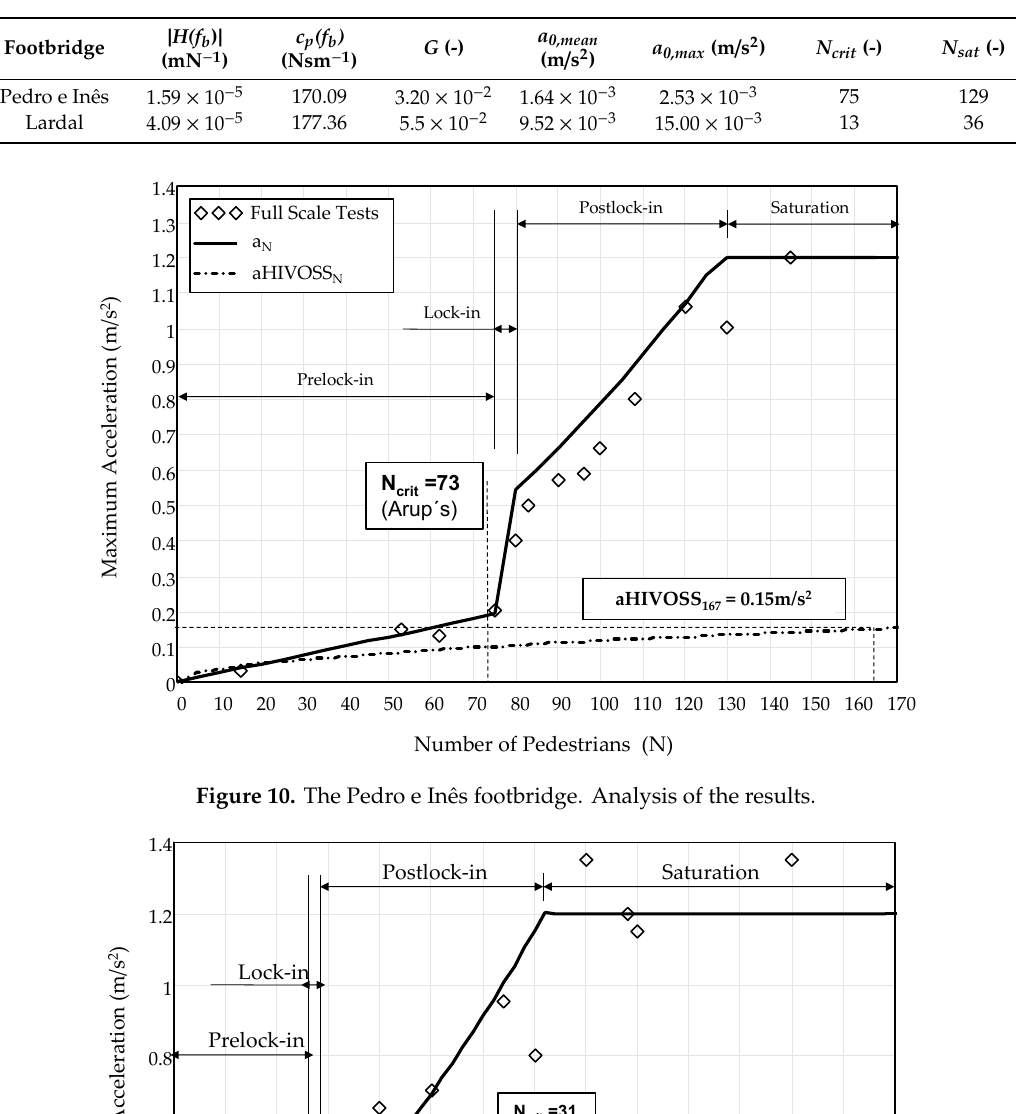
Table 3. Numerical response simulation. Results obtained by applying the proposed method.